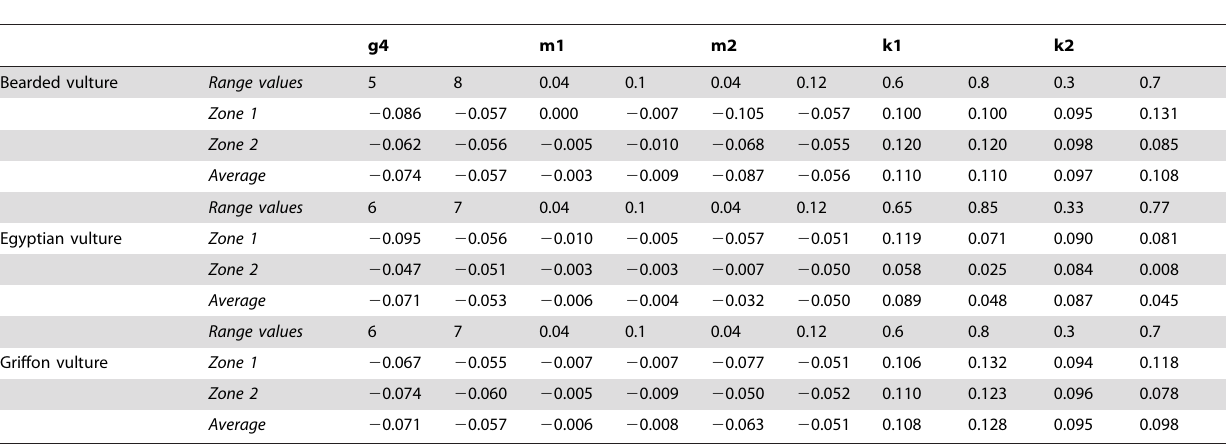
Table 1. Results of the elasticity analyses of the demographic parameters of the griffon, Egyptian and bearded vulture population and separately for the two geographical areas (Zone 1: Pyrenees; Zone 2: Pre-Pyrenees).